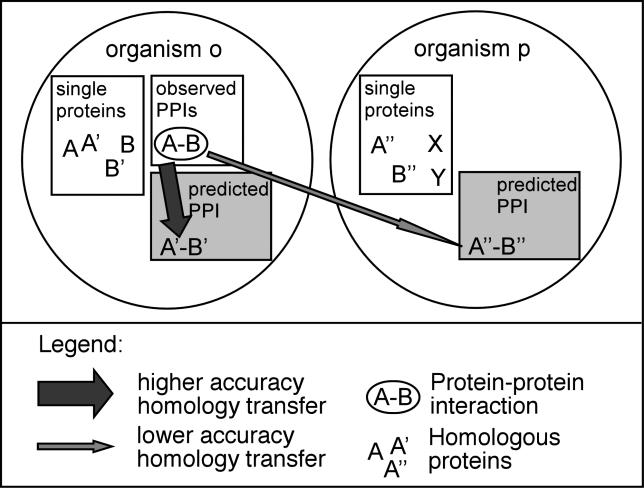
Concept of Homology Inference and InterologsInterologs are two pairs of protein interactions that fulfill the following conditions: (A interacts with B) + (A is similar to A′) + (B is similar to B′) → (A′ interacts with B′). All quadruples (A, B, A′, B′) for which this relation is true are referred to as interologs [37,79]. To illustrate our analysis, we have to extend this simple relation. Assume that a physical protein–protein interaction (PPI) between proteins A and B is observed in organism o. If A and B are both sequence similar (above a certain threshold) to two other proteins A′ and B′ in the same organism o, we should be able to infer the physical interaction between A′ and B′. Note that both pairs, A/A′ as well as B/B′, have to be above the particular similarity threshold for us to be able to make this inference. Thus, we neither use an average similarity of both pairs (A/A′ and B/B′) nor a minimum similarity for just one pair (A/A′ or B/B′). Now let us assume that we have another pair of proteins A″ and B″ in another organism p, and that both are as similar to A and B as are A′ and B′, respectively. One of our findings was that homology transfers A-B → A′-B′ were more reliable than those from A-B → A″-B″.